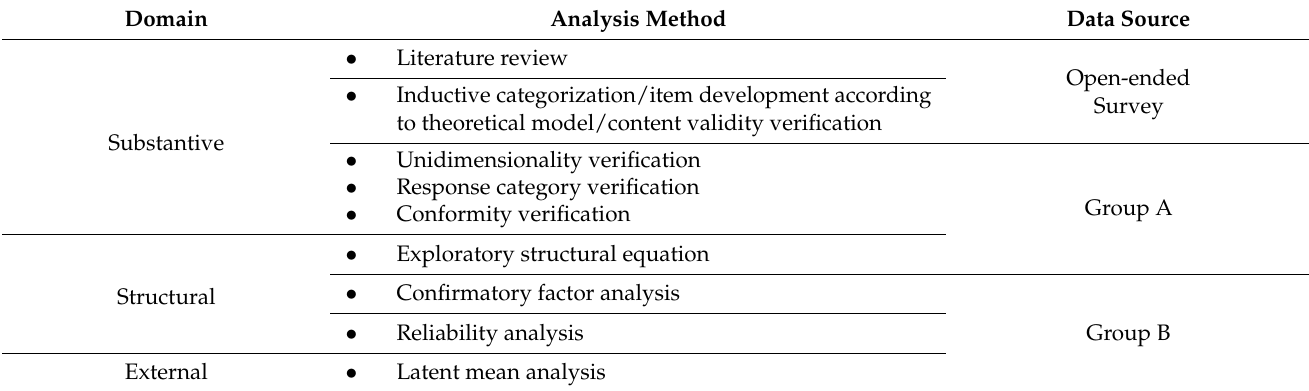
Table 3. Construct validity